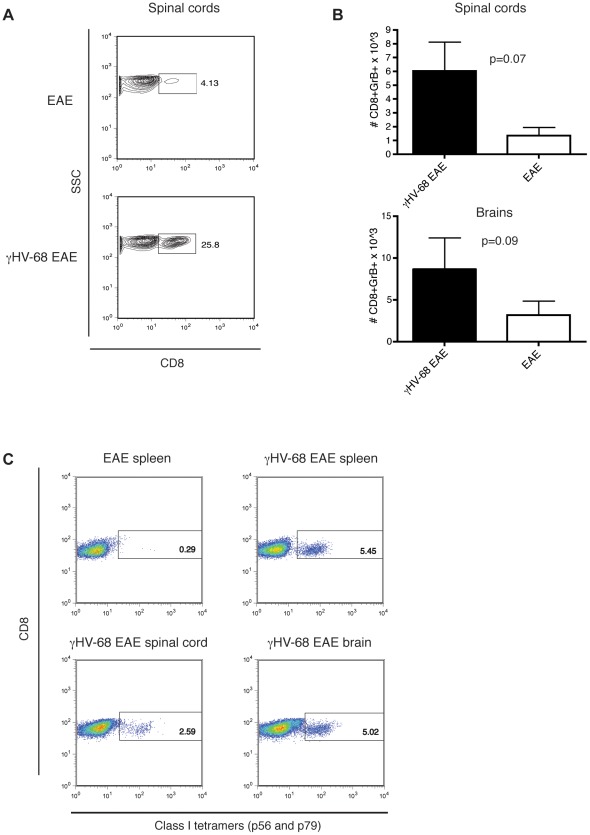
CD8 T cells infiltrating in the CNS of γHV-68 EAE mice express granzyme B and are specific for viral proteins.Mice were infected with γHV-68 or MEM only. Five weeks p.i. EAE was induced. At day 14–16 post EAE induction (mean clinical score of 3 for γHV-68 EAE mice, EAE mice were harvested at the same time), mice were perfused, brains and spinal cords were harvested and processed to isolate immune infiltrates. (A) Representative FACS plots showing the percentages of CD8 T cells infiltrating in the spinal cords (similar results were obtained in the brains) and histogram (B) showing the number of CD8+ granzyme B+ T cells infiltrating in the spinal cords and in the brains (immune cells were not restimulated before granzyme B staining). Two separate experiments with 6 mice/group, data analyzed with t-test. (C) Representative FACS plots showing percentages of CD8+ T cells with TCR specific for γHV-68 epitopes (p56 and p79) in the spleen of EAE mice (negative control); in the spleen of γHV-68 EAE mice (positive control; 3.3±1.6%), in the spinal cord (3.4±0.5%) and in the brain (4.9±0.5%) of γHV-68 EAE mice. Two separate experiments with 6 mice/group, errors are s.d.